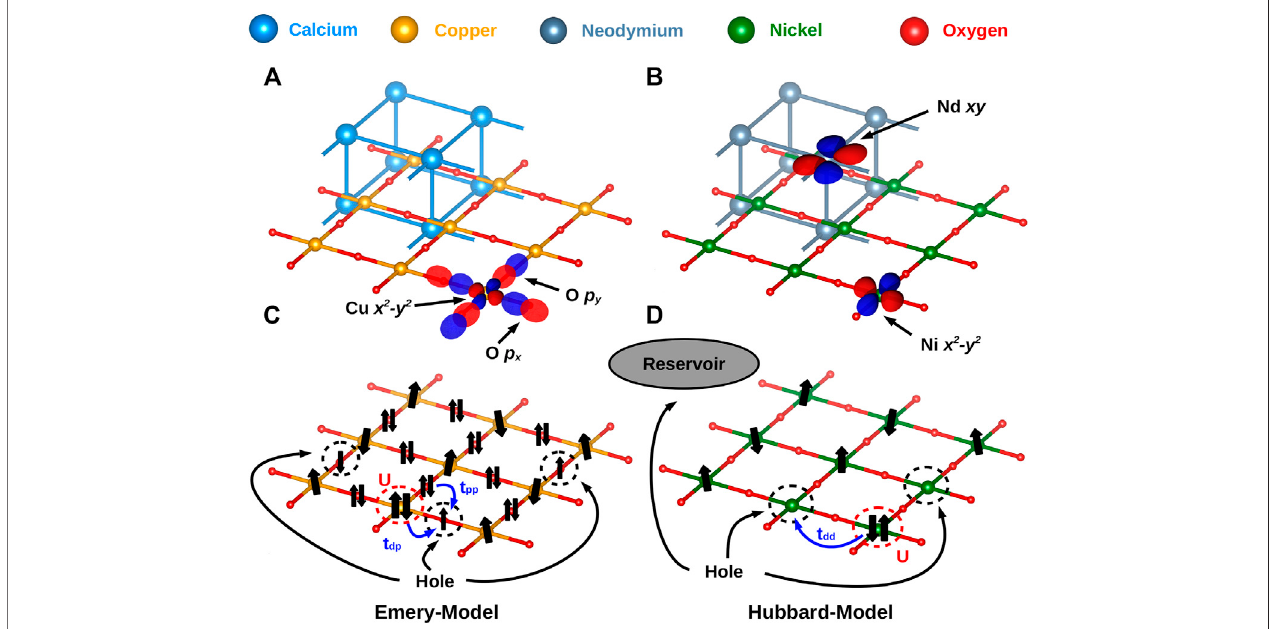
FIGURE1 | Crystal lattice and most importantorbitals for (A) cuprates and (B) nickelates. (C) Forcuprates,the arguably simplest model is theEmery model witha half- fi lledcopper 3 d x 2 − y 2 band andholesintheoxygen2 p orbitals thatcanhoptoother oxygen( t pp ) andcopper sites( t dp )where double occupationsaresuppressed by theinteraction U . (D) Fornickelates,wehaveaNi-3 d x 2 − y 2 -bandHubbardmodelwhich,however,onlyaccommodatespartoftheholesinducedbySr-doping.Theothers go to the A pocket stemming from the Nd 5 d xy band and acting as a decoupled reservoir.